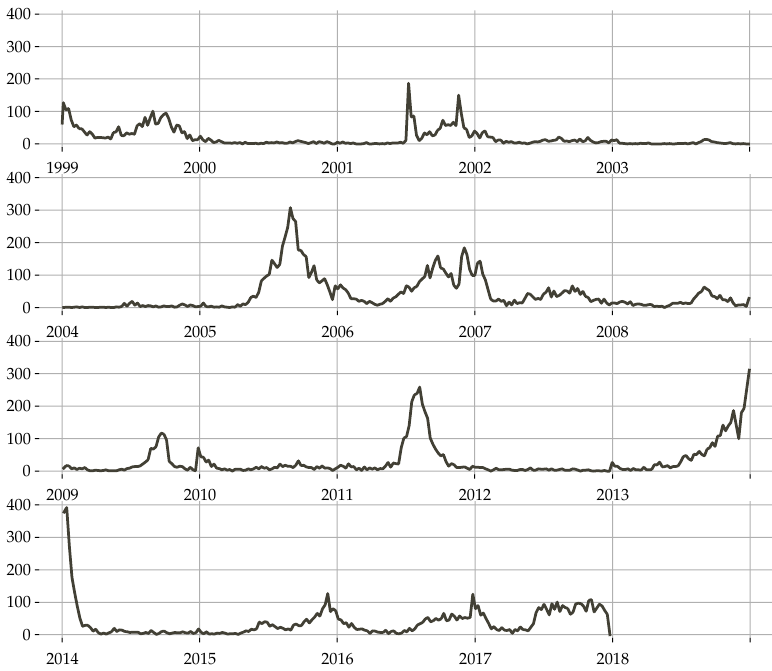
Figure 1. Map with the scale distribution of the accumulated number of reported cases of Dengue in the Metropolitan